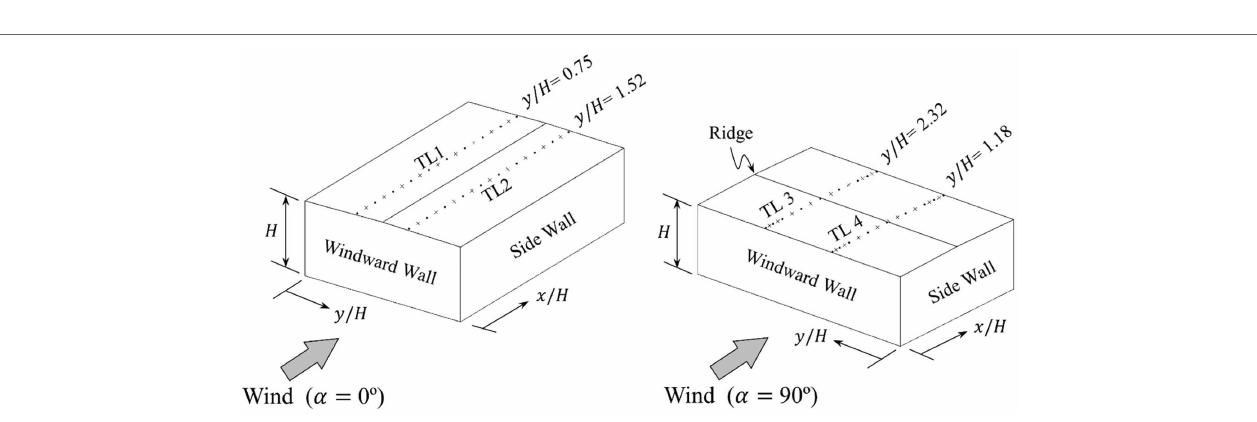
(Holmes, 1981; Sadek and Simiu, 2002). The magnitude of skew- ness values at the leading edge decreases from -0.8 to -1.4 with increasing turbulence. Kurtosis values rise from ~5 to ~8 close to x / H = 0. Furthermore, in smoother freestream flows (e.g., I u , H = 9.7%), near Gaussian behavior appears to occur from x / H = 1.0 to 1.5. The roughest upwind cases show close to zero